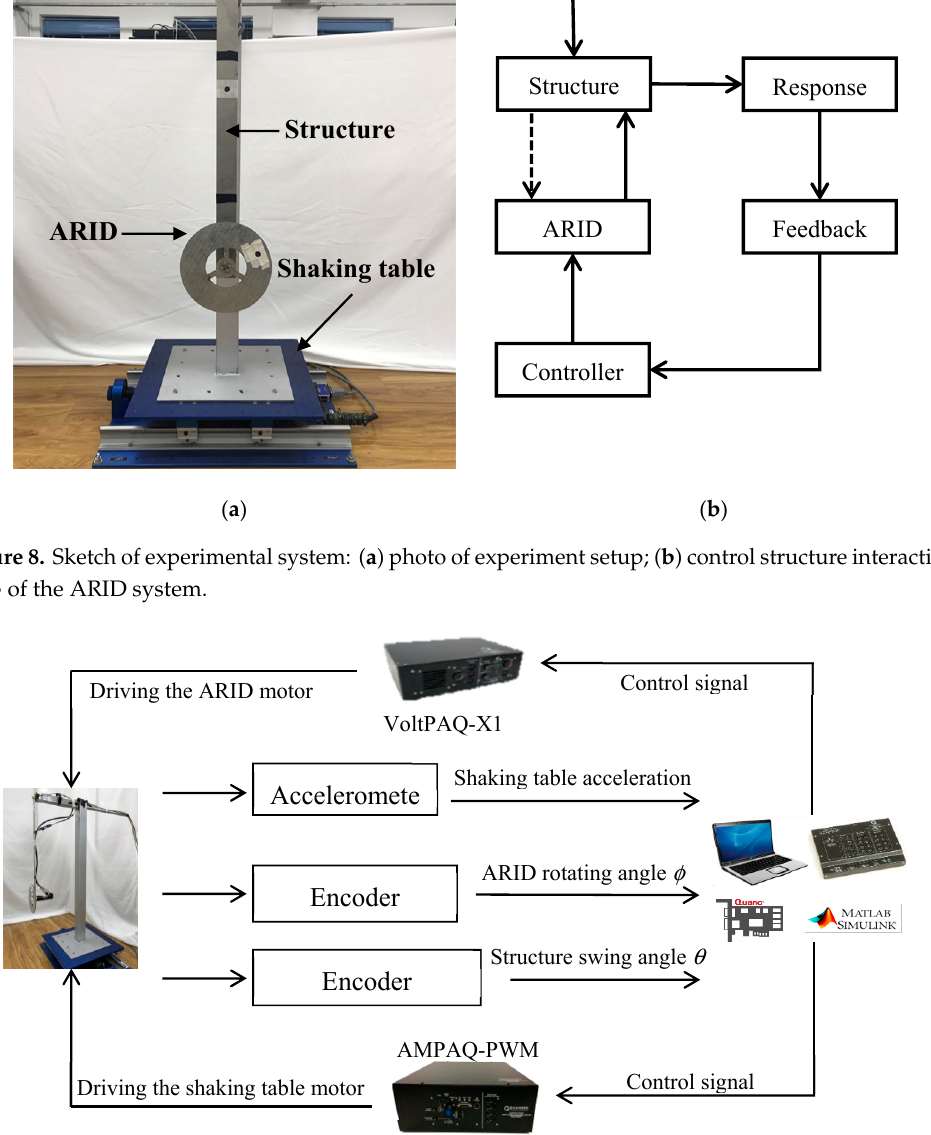
Figure 9. Schematic of the experiment system.